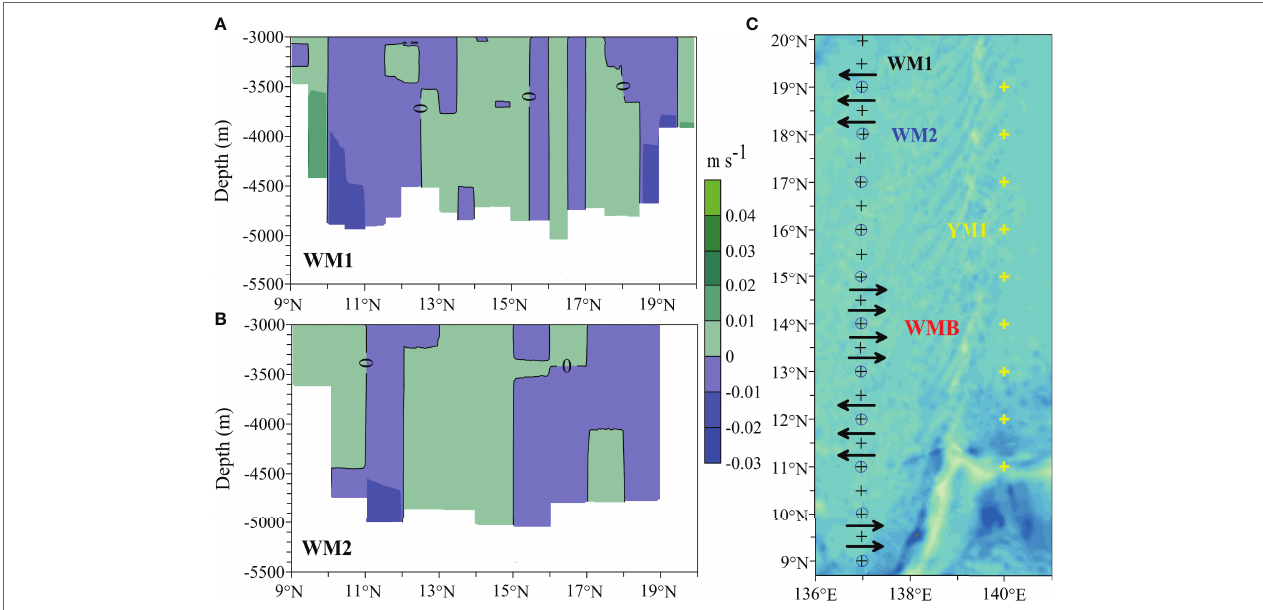
FIGURE 9 | Zonal flows at sections WM1 (A) and WM2 (B) in the West Mariana Basin, and their general pattern (C)